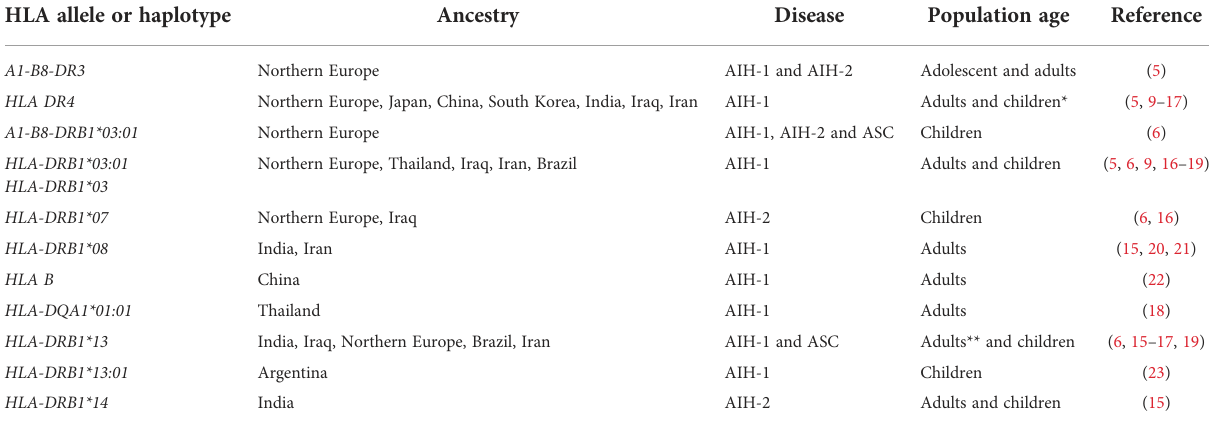
TABLE 1 Main HLA alleles and haplotypes predisposing to autoimmune hepatitis. HLA allele or haplotype